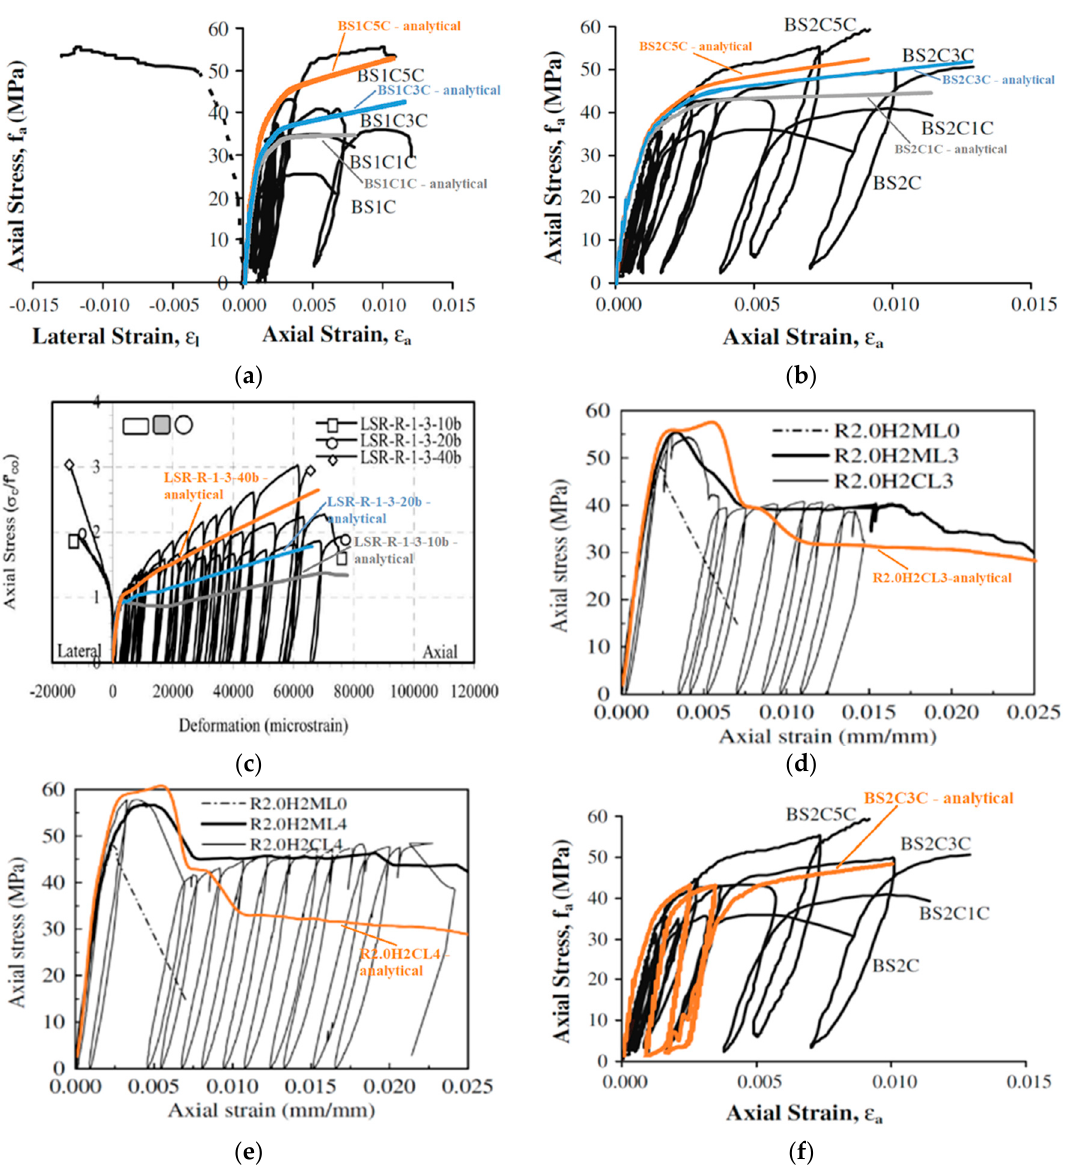
Figure 4. FE analysis predictions versus experimental stress-strain results for ( a ) specimen series BS1C by [2]; ( b ) specimen series BS2C by [2]; ( c ) specimen series LSR-R-1-3 by [20]; ( d ) specimen R2.0H2CL3 by [28]; ( e ) specimen R2.0H2CL4 by [28] and ( f ) specimen BS2CL3 by [2].